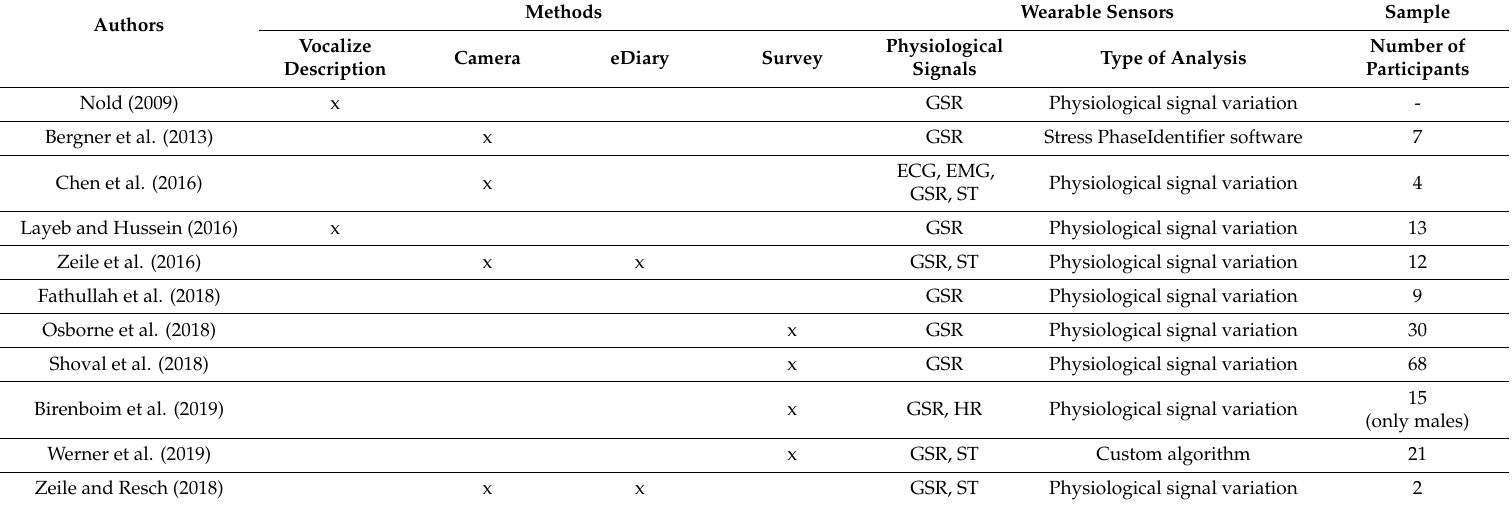
Table 1. Summary of literature review on strategies for combining other methods with wearables for investigating emotional experiences in urban